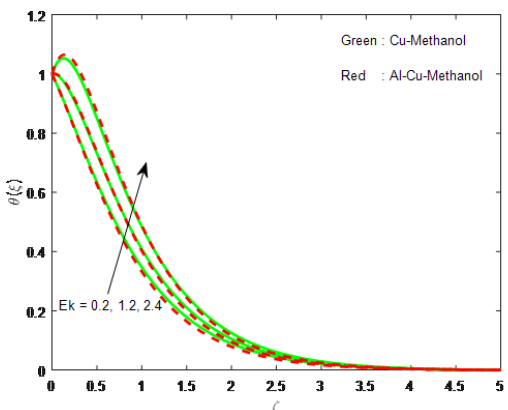
Fig. 5: Impression of Ek on θ ( ξ )